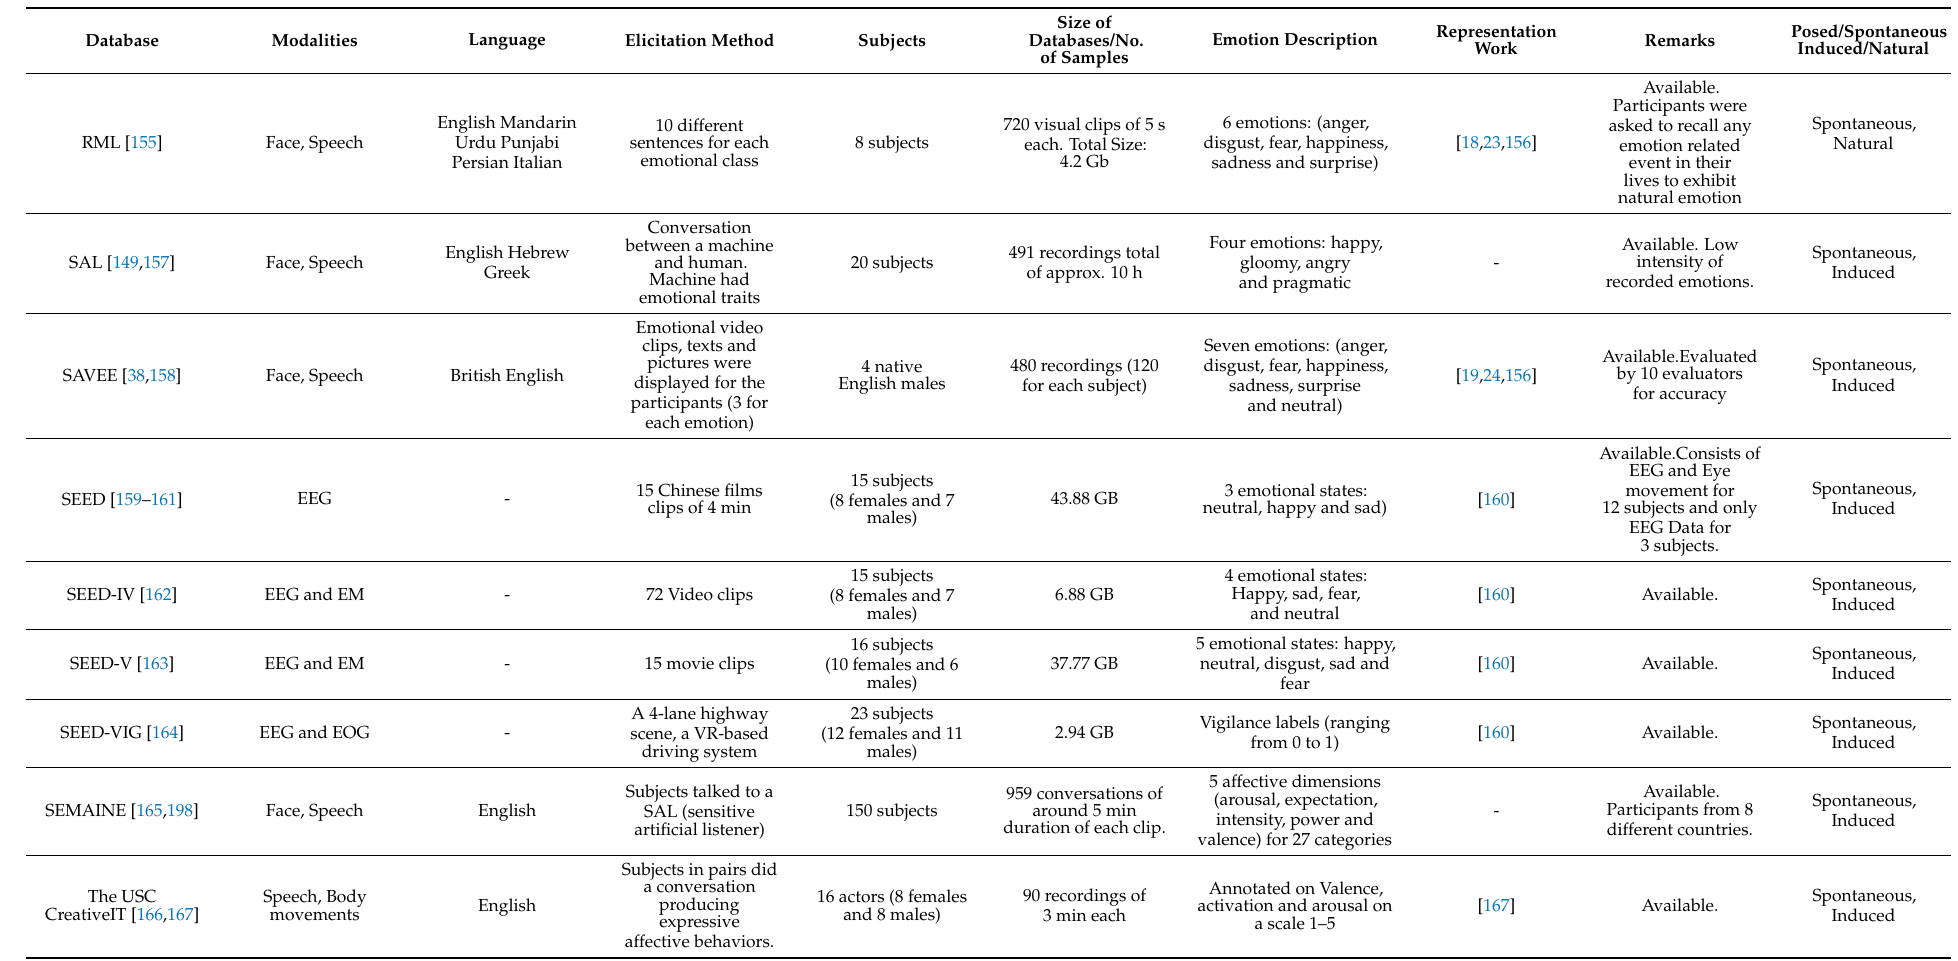
Spontaneous, Induced